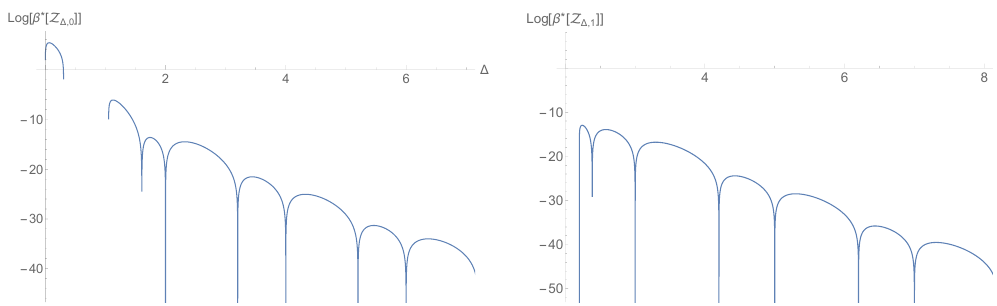
. In this plot, we set 5